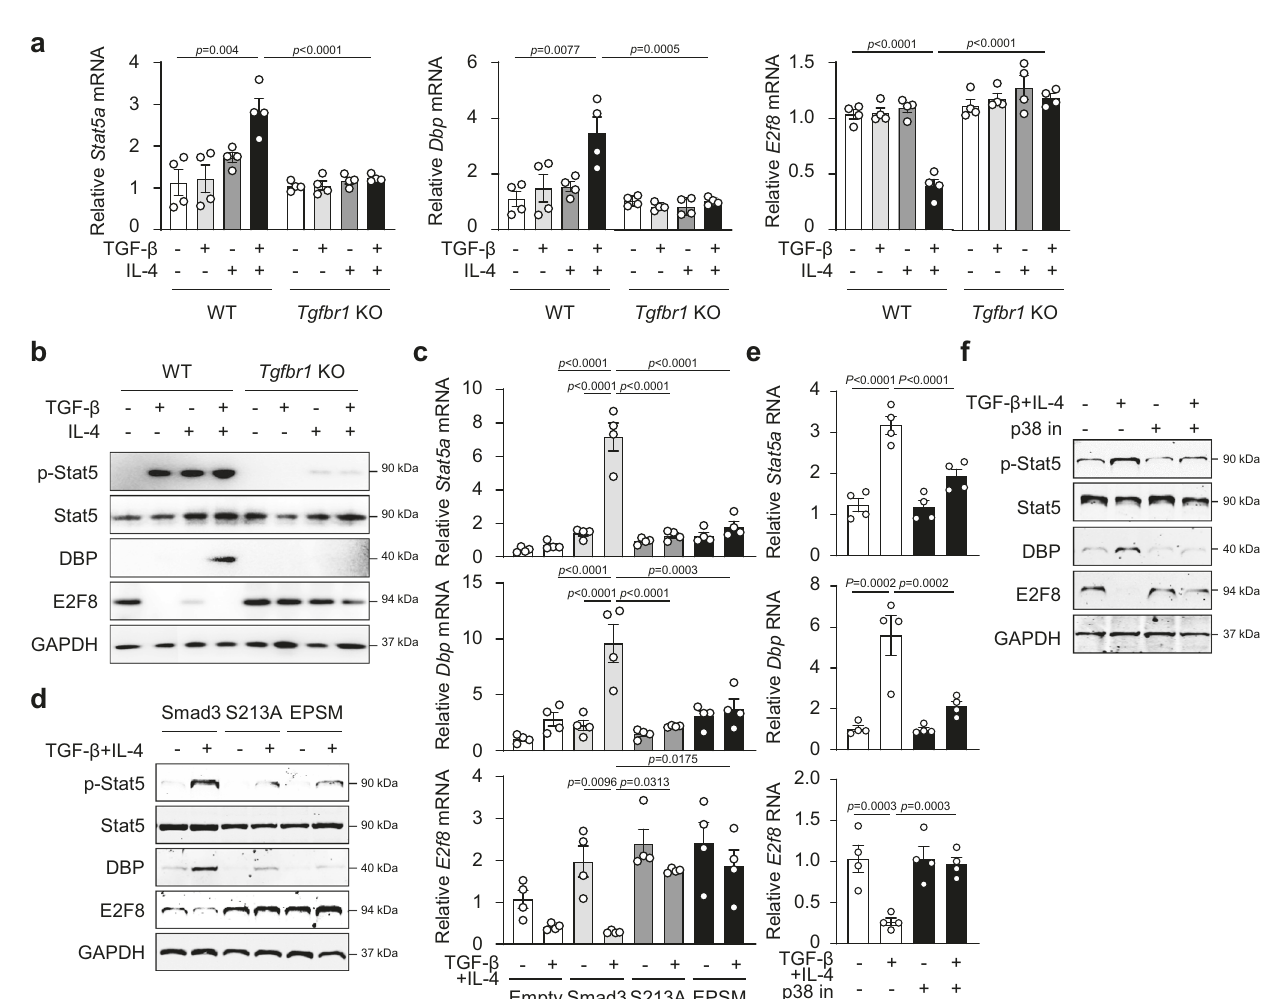
Fig. 3 | TGF- β plus IL-4 signaling increases DBP but decreases E2F8 during Th9 differentiation.a RT-PCRanalysisand b WesternblottingofStat5,DBPandE2F8in WT and Tgfbr1 KO CD4 + T cells cultured with TGF- β , IL-4 or TGF- β plus IL-4. ExpressionofStat5a,DBPandE2F8duringTGF- β andIL-4stimulationinWT,S213A- or EPSM-Smad3 mutants transfected CD4 + T cells c , d or p38 inhibitor-pretreated